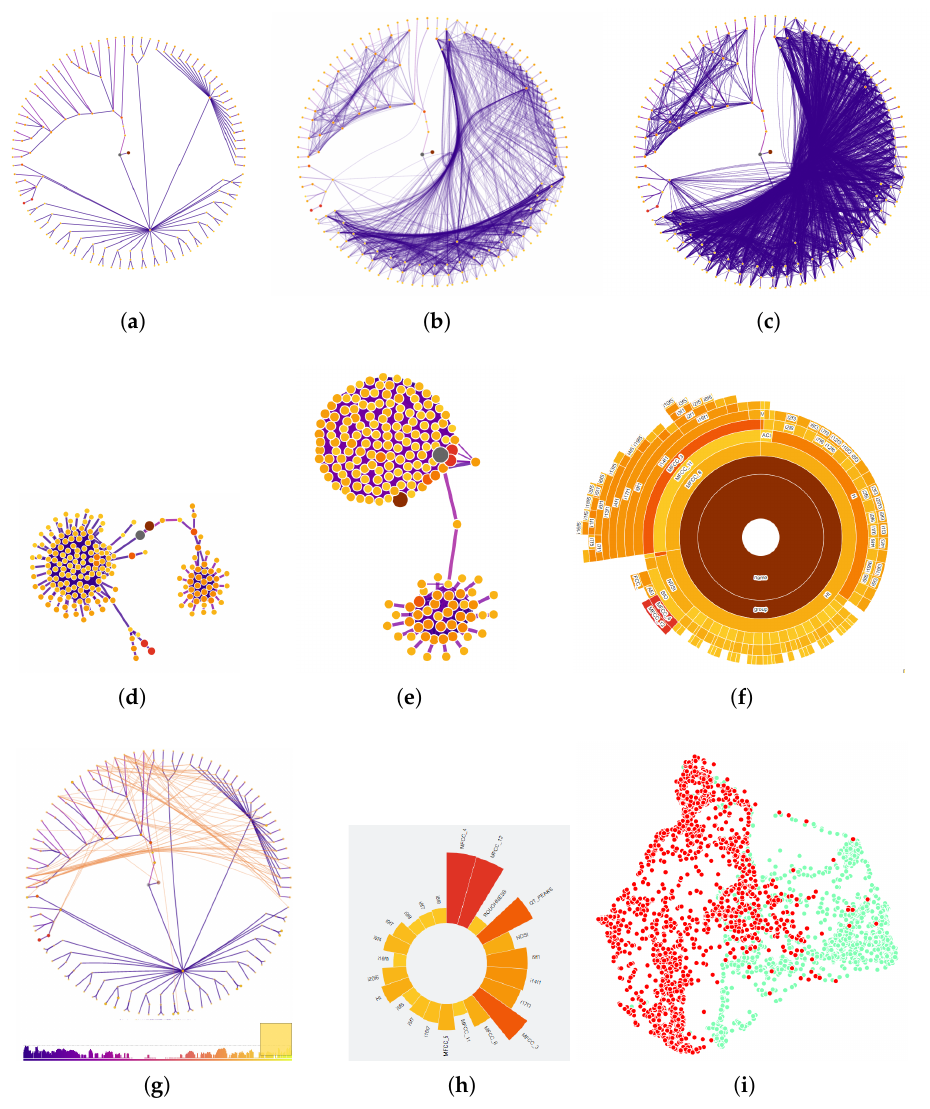
Figure 4. Soundscape data from two forest areas in Costa Rica. ( a ) Initial similarity minimum spanning tree (MST). ( b ) Added edges in increasing order of similarity between nodes (features). ( c ) Further edges added to ( b ). Three groups of features can still be observed. ( d ) Force-based layout identifying three main groups of features. ( e ) With further edge addition still two separate groups of features remain. ( f ) Same tree from ( a ) presented as sunburst. ( g ) Addition of low similarity edges employing the